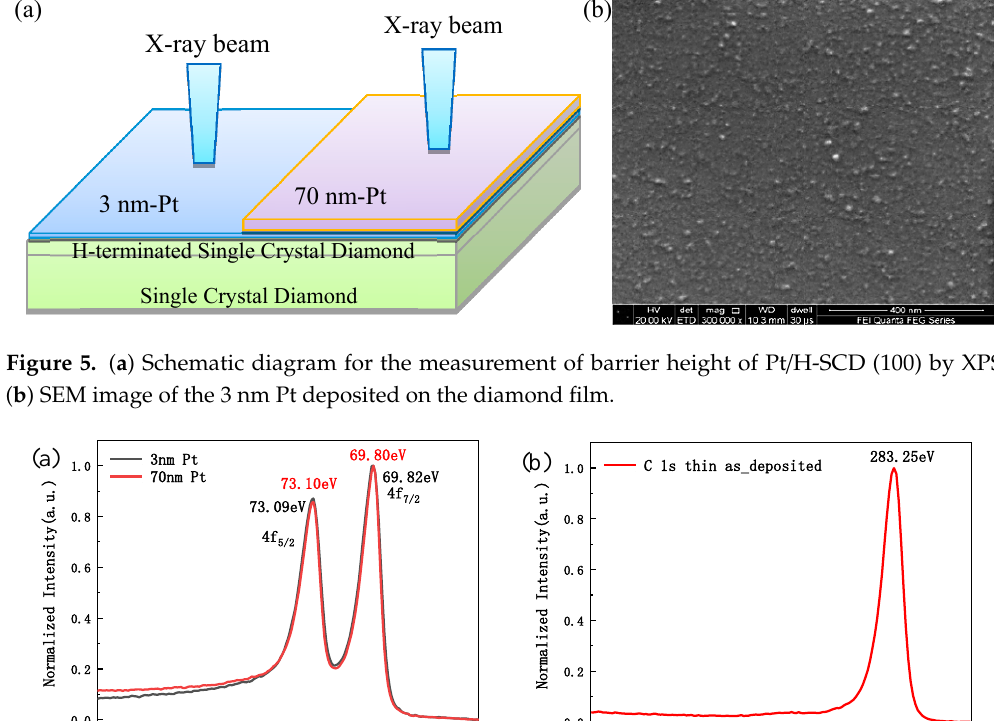
spectrums of C 1 s peaks for the as-fabricated sample.